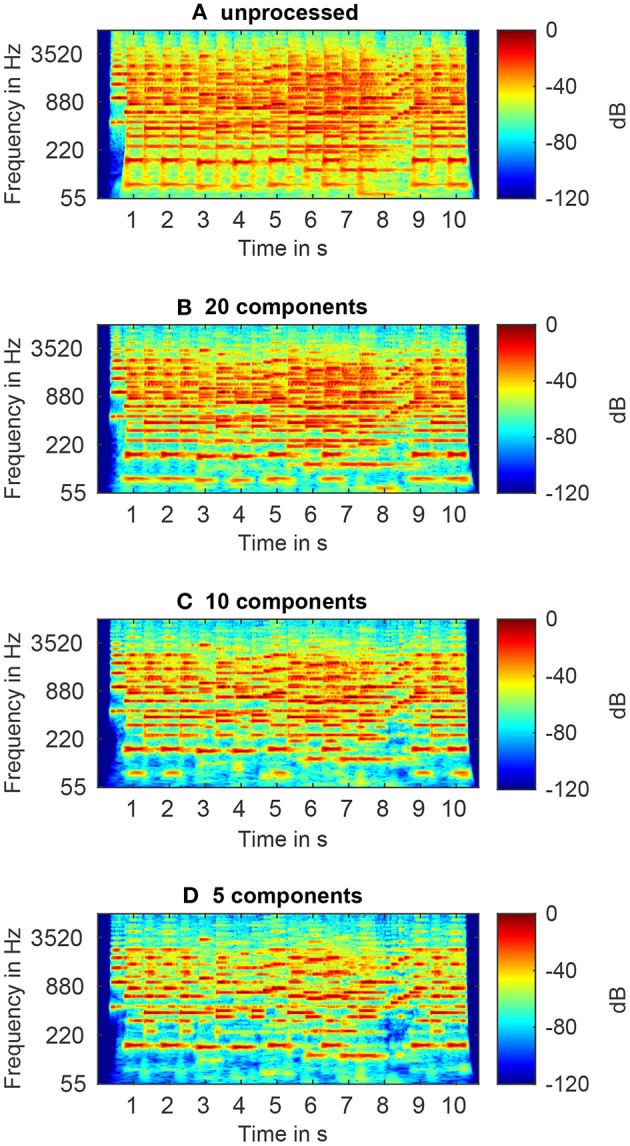
CQT spectrograms of an unprocessed signal (A), and spectrally reduced signals with 20 (B), 10 (C), and 5 (D) retained components.